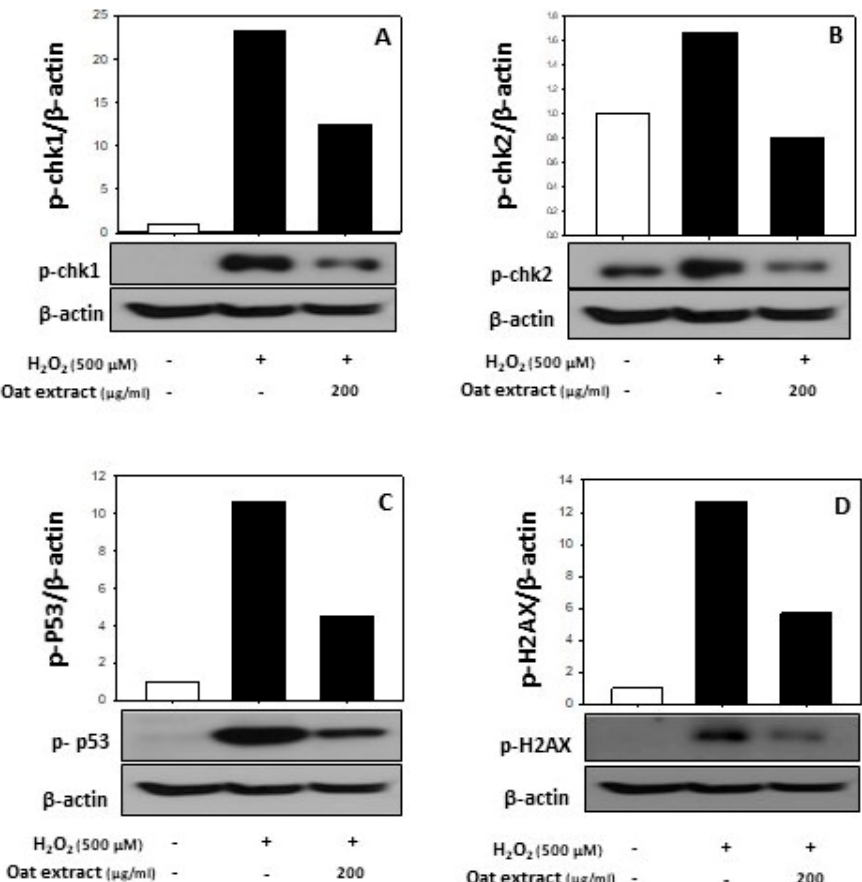
Figure 4. Effects of oat ( Avena sativa cv. Daeyang) 80% ethanol extract on the expression of phospho- chk1 ( A ), phospho-chk2 ( B ), phospho-p53 ( C ) and phospho-H2AX ( D ) in human keratinocytes HaCaT. Cells were treated with various concentrations (50–200 µ g/mL) of oat 80% ethanol extracts for 24 h, followed by treatment with 500 µ M H 2 O 2 for 2 h. Total cell lysates were prepared at the same time, and Chk-1, Chk-2, H2AX and p-53 protein levels were assessed using immunoblotting. β -Actin was used as an internal